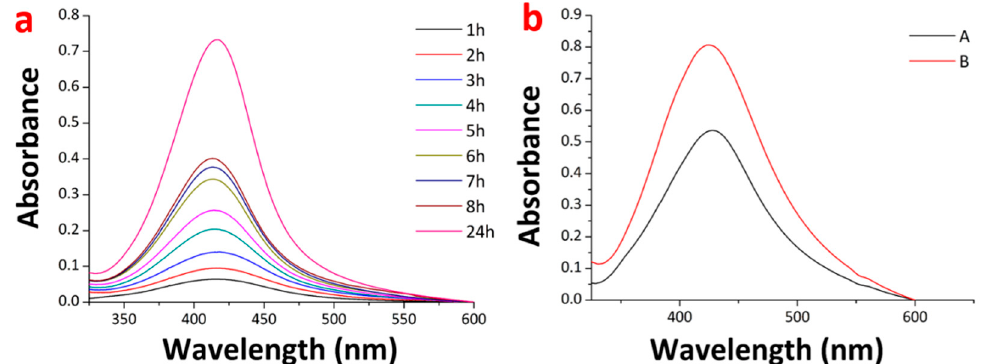
Figure 8. UV/Vis analyses of the surrounding solution over time for sample B ( a ) and after 24 h for samples A and B ( b ).